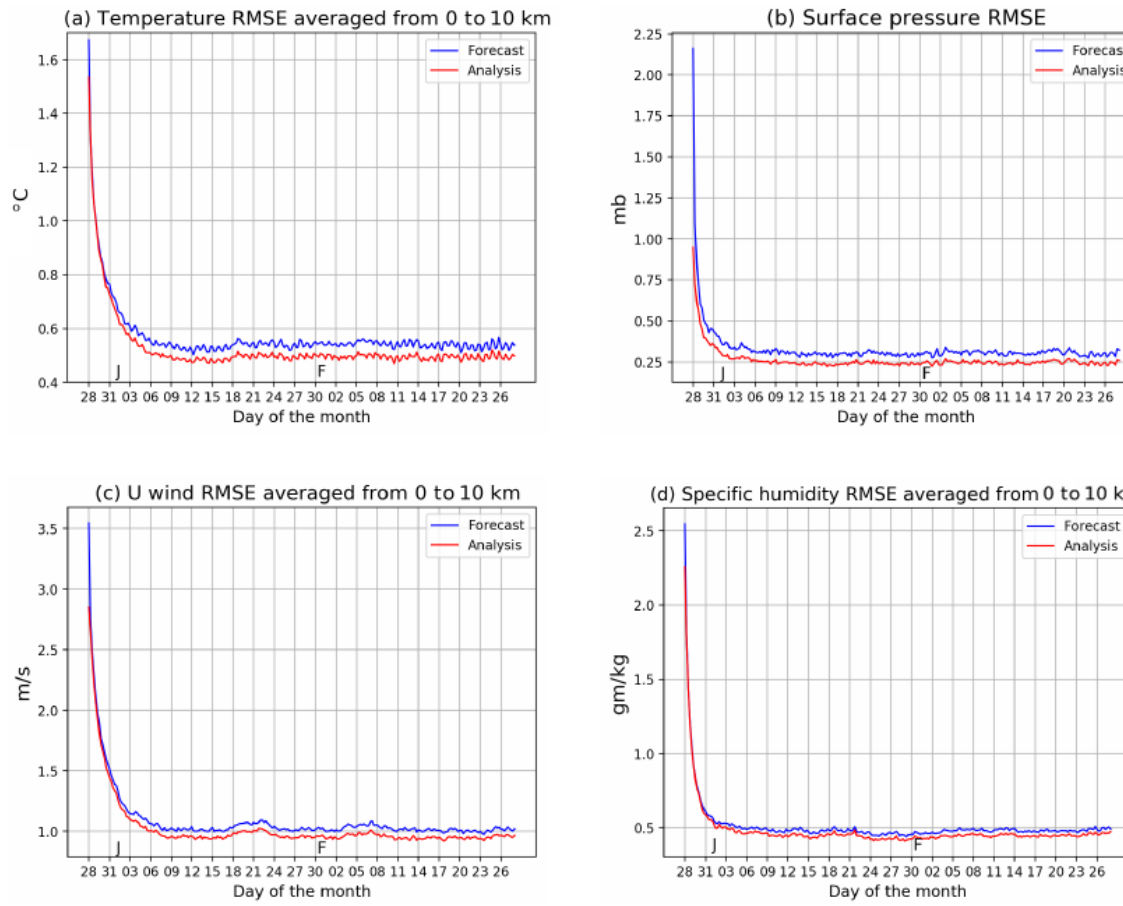
Figure 5. The time series of the RMSE of meteorological variables from the EXP_CNTRL are shown. J and F, marked on the x axis, indicate the start of January and February, respectively. The analyses is shown in red, and the forecast RMSE is shown in blue.